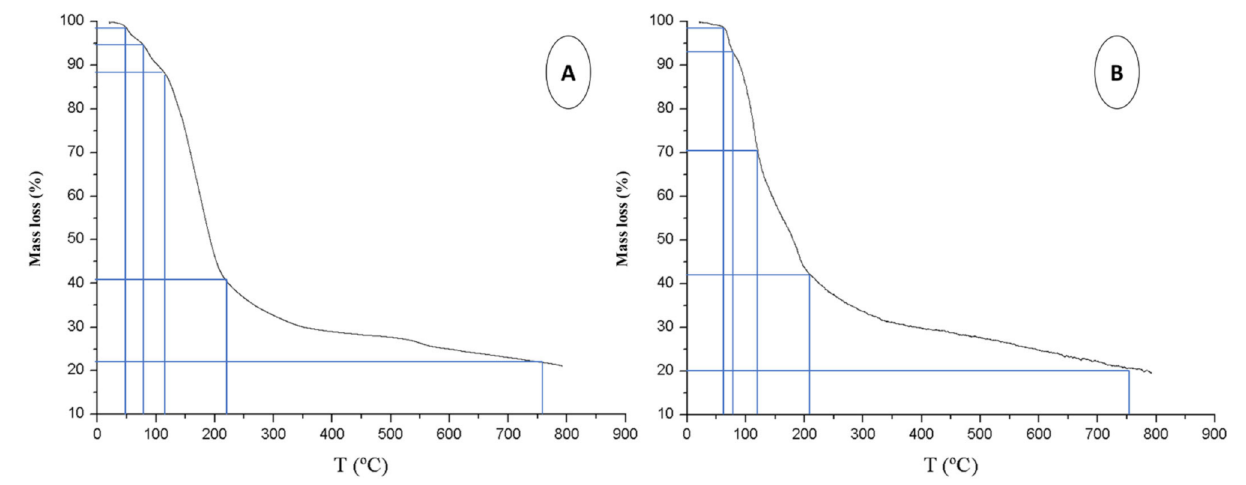
Figure 2. Thermogravimetric curve obtained in the pyrolysis of orange tree pruning ( A ) and orange waste ( B